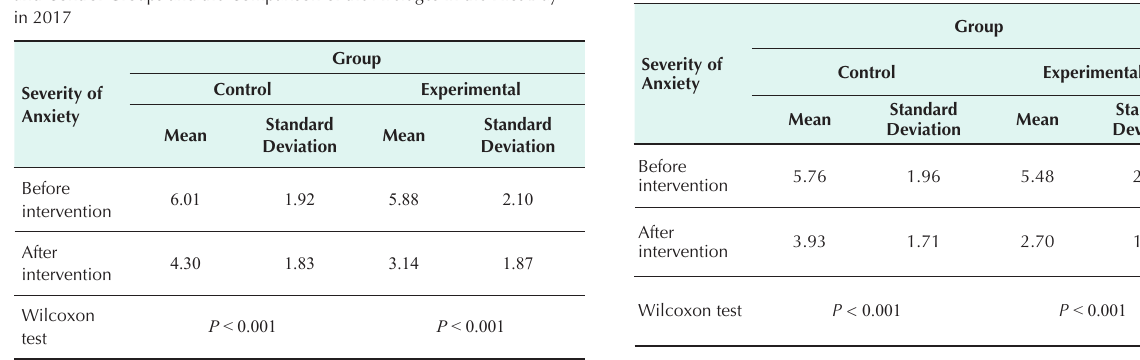
Table 2. Numerical Indices of Anxiety in Studied Patients in Experimental and Control Groups and the Comparison of the Averages in the Second